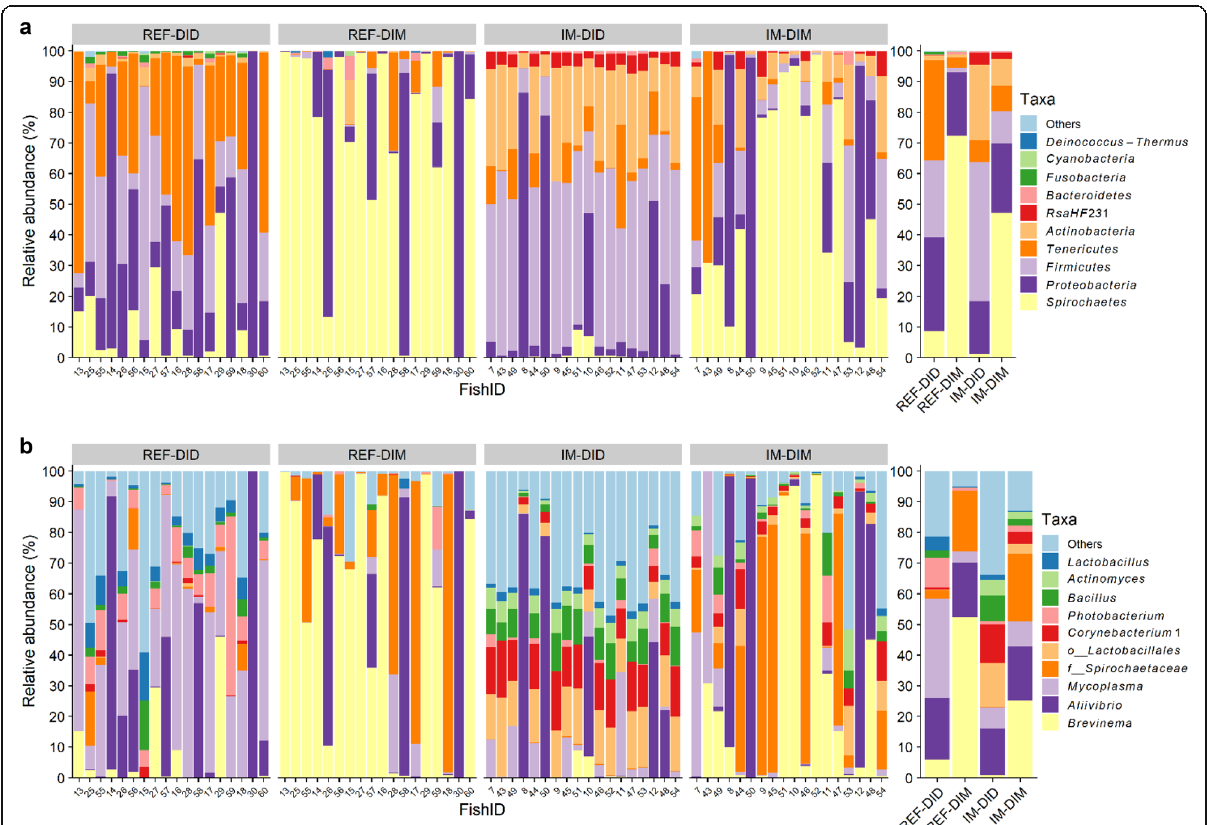
Fig. 1 Top 10 most abundant taxa of all samples at phylum ( a ) and genus ( b ) level. The samples are grouped by the sample type. The mean relative abundance of each taxon within the same sample type is displayed on the right side. o__ , order; f __, family; REF, reference diet; IM, insect meal diet; DID, distal intestine digesta; DIM, distal intestine mucosa